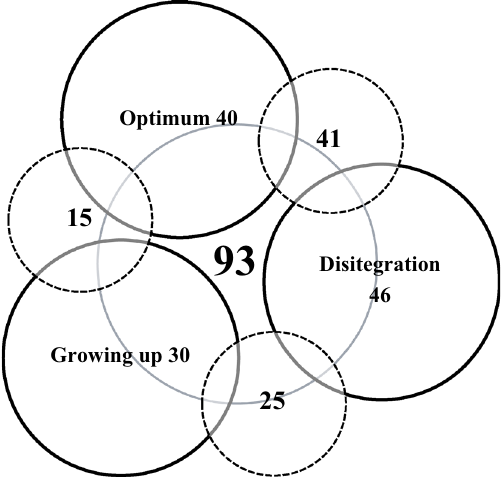
Figure 5. Venn diagram – shows the absolute recorded unique numbers of species in each stage (solid circles). Between each stage are the species that are shared within the stages (dashed circles) and in the middle is the sum of species shared for all stages simultaneously.